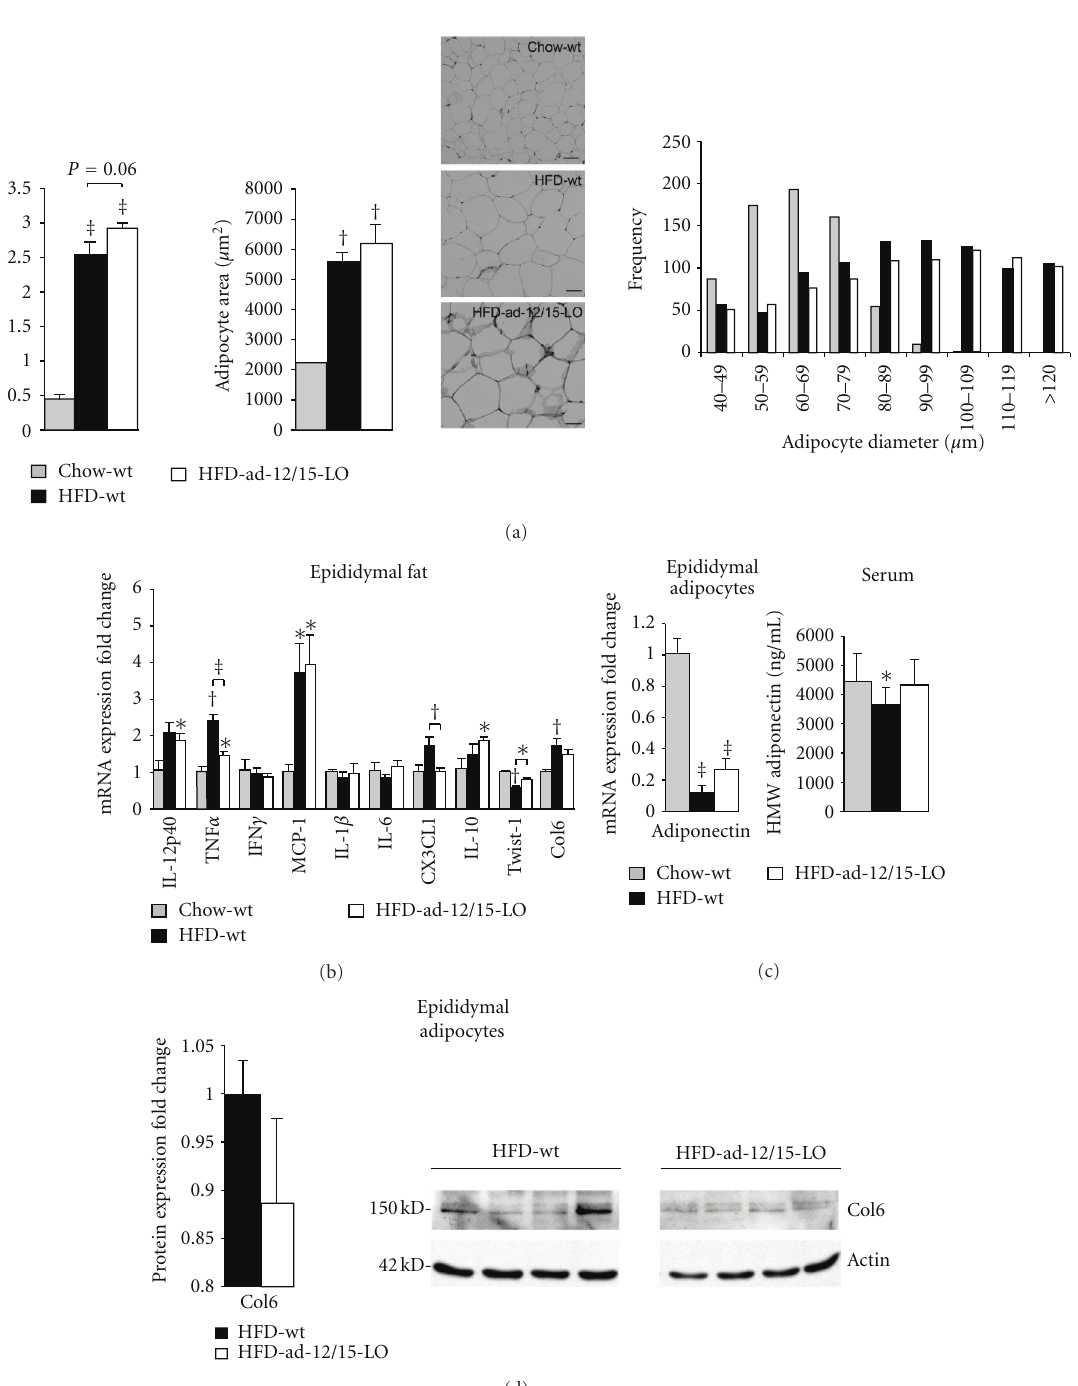
Figure 3: Fat-specific 12/15-LO-deficient mice exhibit decreased inflammation in adipose tissue following a high-fat diet regimen. (a) Epididymal adipose tissue weight and adipocyte size were measured in mice after the 16-week feeding regimen. Hematoxylin and eosin stained sections of epididymal adipose tissue are shown. Scale bar = 50 μ M. (b) mRNA measurements of key proinflammatory and anti- inflammatory genes were examined by RT-PCR in epididymal adipose tissue from mice. (c) Adiponectin mRNA and high-molecular-weight (HMW) adiponectin protein were measured in isolated epididymal adipocytes and serum by RT-PCR and ELISA, respectively. (d) Protein measurement of collagen 6 (Col6) was performed from isolated epididymal adipocytes and quantified. Representative western blots are shown, and separate panels for each antibody represent the same exposure from the same gel. All mRNA and protein data were normalized to total actin, and the fold changes in expression were calculated relative to control. All data represent the means ± SEM; n = 3–6. ∗ P < 0 . 05, † P < 0 . 02, ‡ P < 0 . 001 versus control, unless otherwise indicated. Chow: chow diet; HFD: high-fat diet; wt: wild type 12/15 - LO loxP/loxP